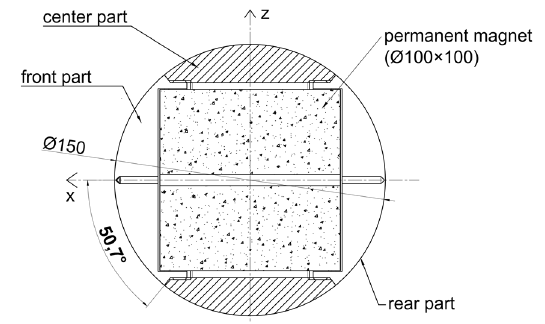
Figure 3. Sphere model.